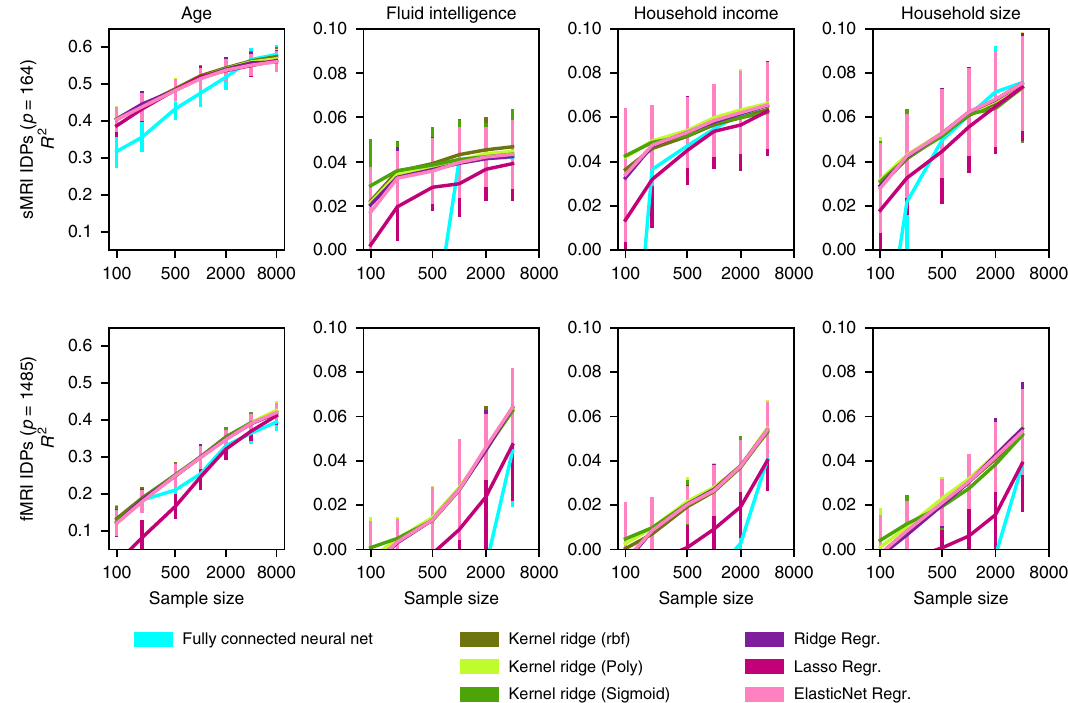
Fig. 5 More dif fi cult prediction goals show no evidence of exploitable nonlinear relationships in brain images. To complement the easily predictable targets of age and sex, we reiterated our benchmarking analyses on more complex demographic indices and lifestyle factors, including IQ, socioeconomic status, and household size. Ridge and ElasticNet regression provide a linear baseline that performed on par with more powerful kernel and deep neural network models in the prediction of complex target variables ( R 2 , coef fi cient of determination). Lasso approached comparable performance at higher sample sizes. Moreover, the performance of linear models did not consistently saturate. Especially the sample complexity curves for predicting fl uid intelligence from fMRI and household size from sMRI show that we do not appear to be close to fully exploiting the predictive information contained in brain MRI data. Please note that some prediction targets ( fl uid intelligence, household size, and income) were not available for all subjects, which is why the n = 8000 results are missing in some cases. Our observation that powerful machine learning models so far fail to beat linear baselines on brain- imaging data is not limited to the prediction of sex or age, but extends to more complex prediction targets. Error bars = mean ± 1 SD across 20 cross- validation iterations (all